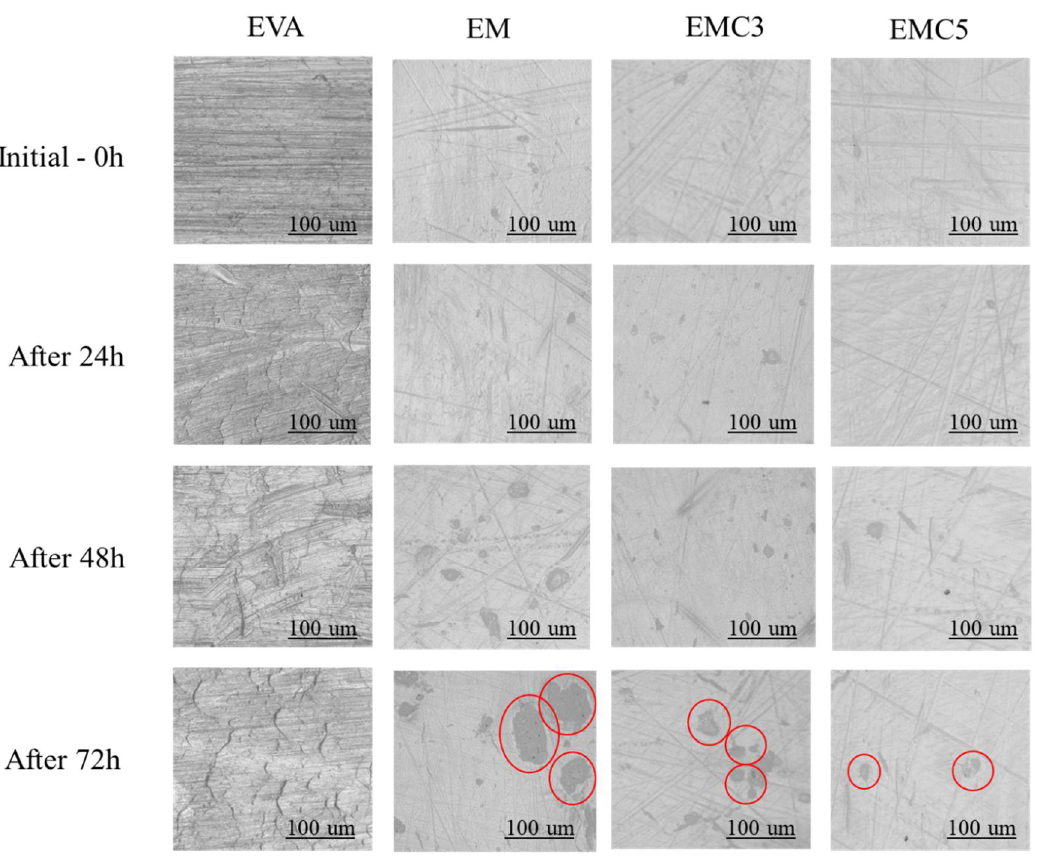
Figure 8. Optical microscope images of the pure EVA and its composites’ surface morphologies before and after exposure to UV, by different times.